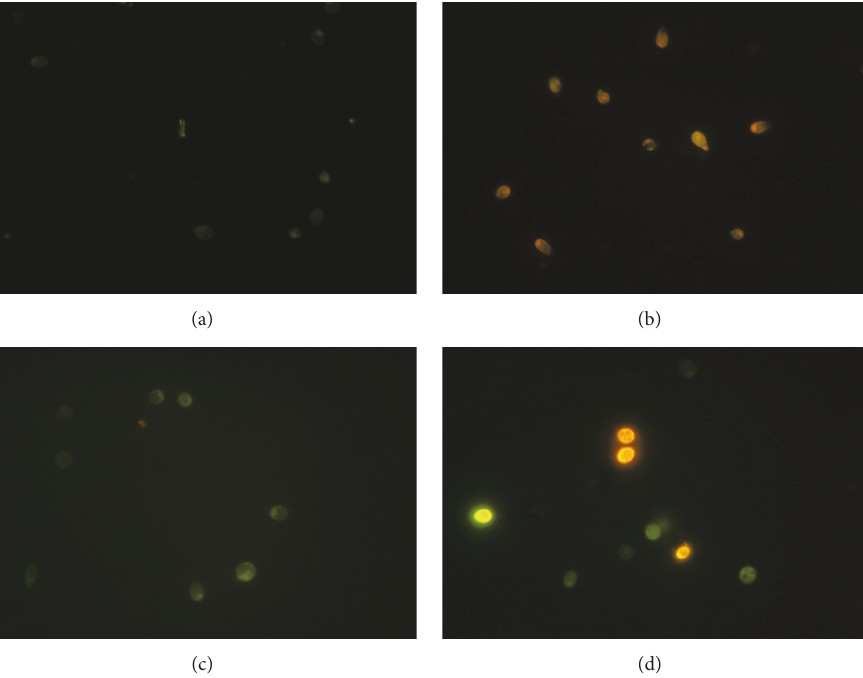
Figure 6: Apoptotic cells on ethidium bromide/acridine orange staining. Cells were observed using fluorescence microscopy. (a) S. apiospermum CBS 117410 without UVC exposure; (b) S. apiospermum CBS 117410 after 15 min of UVC exposure; (c) L. prolificans CM324 without UVC exposure; and (d) L. prolificans CM324 after 15 min of UVC